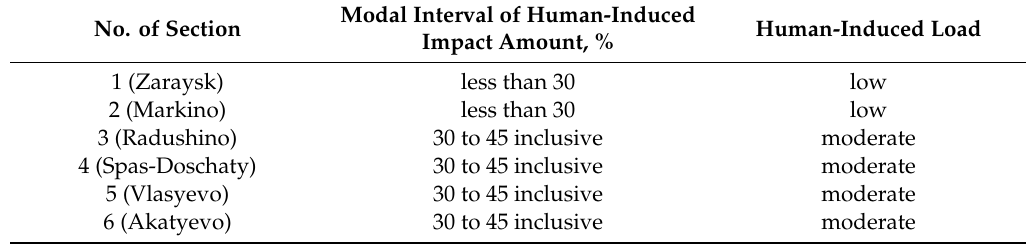
Table 3. Scale to assess the Osetr and Oka rivers ecosystem human-induced load by the amount of human-induced impact.